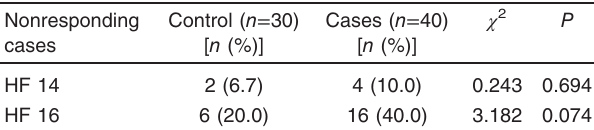
Table 8 Correlation between age and high frequency thresholds in cases group